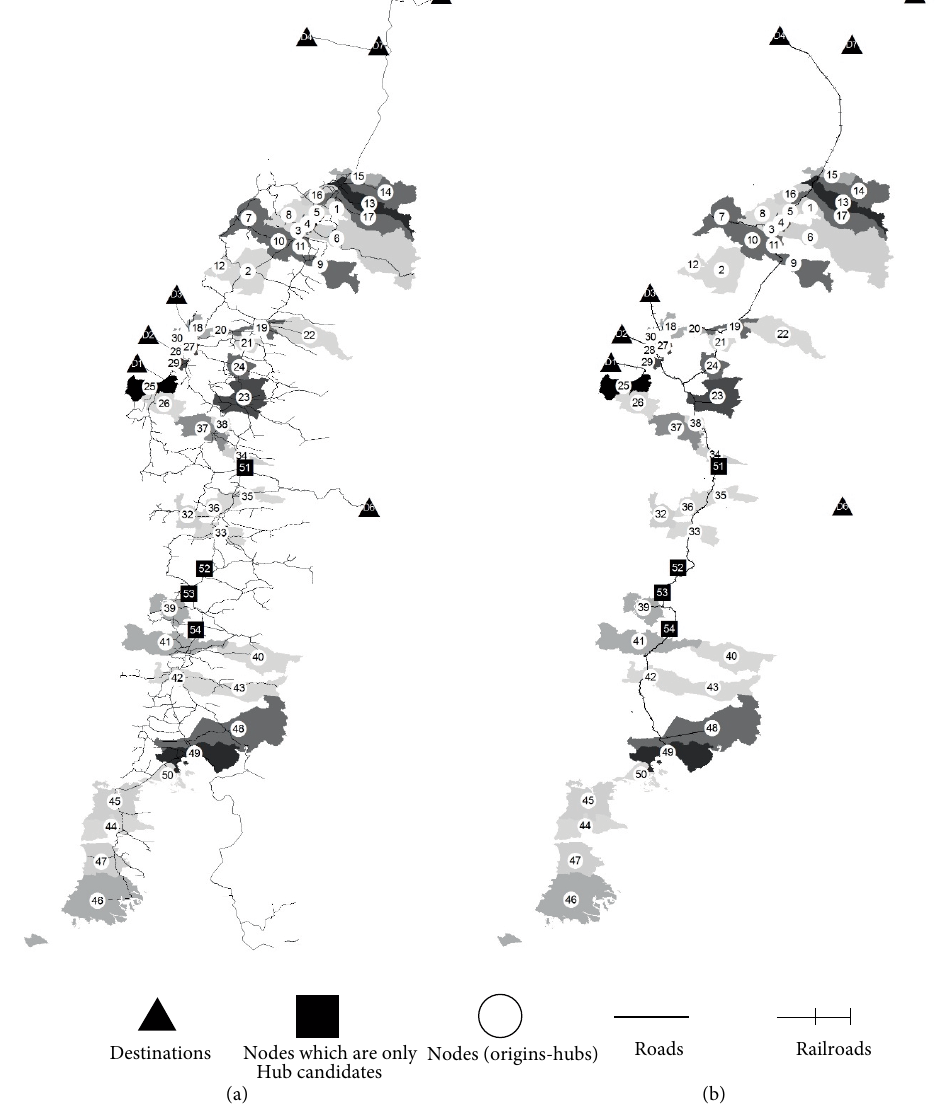
Figure 1: Context situation. (a) The complete system with roads. (b) The study area with rail connectivity.